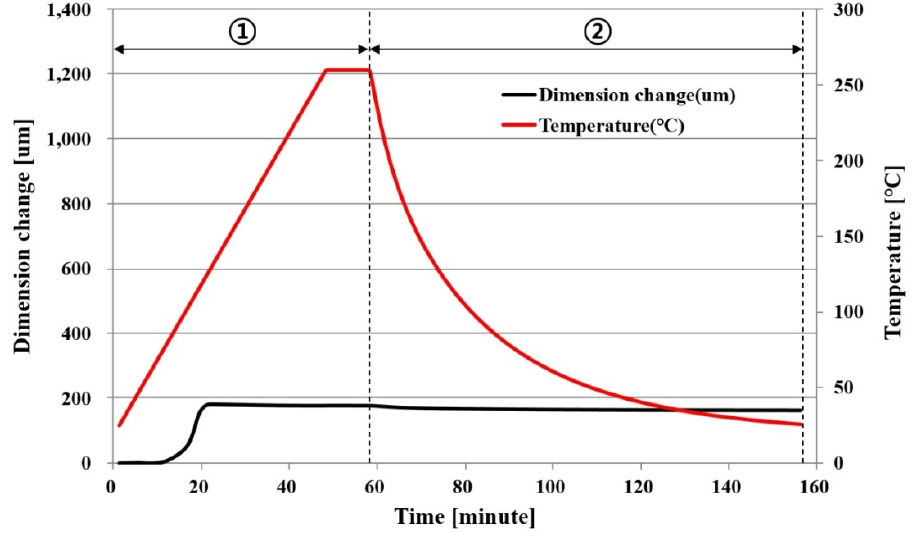
Figure 4. CTE of PPG in a y direction as a function of temperature and time. Table 2. CTE of PPG in a y